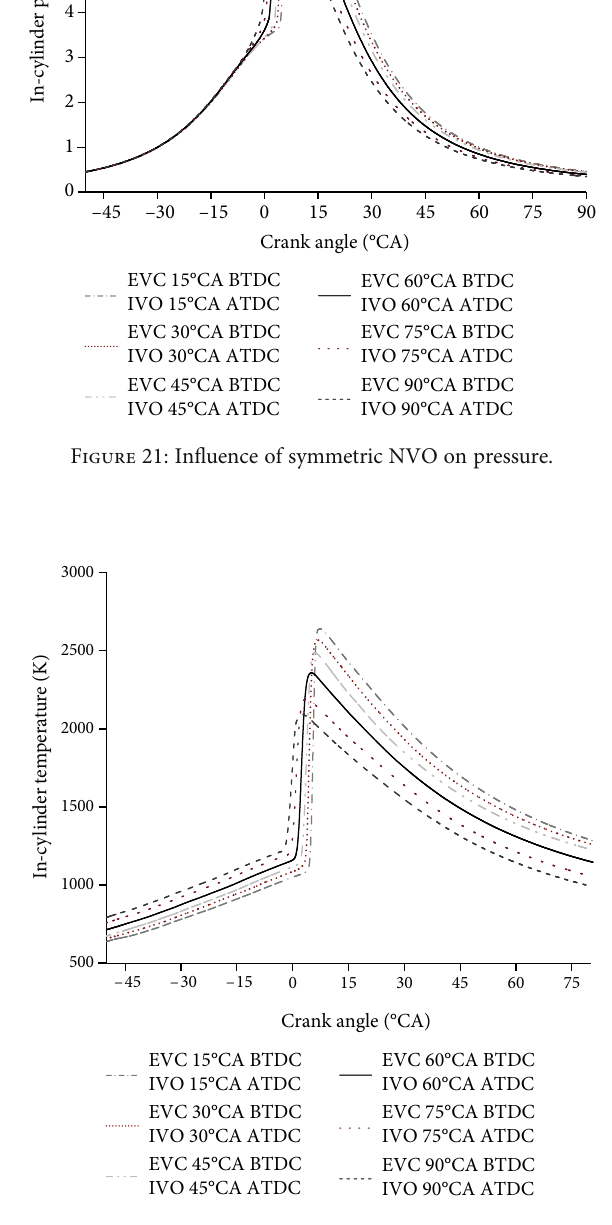
Figure 22: E ff ect of symmetric NVO on